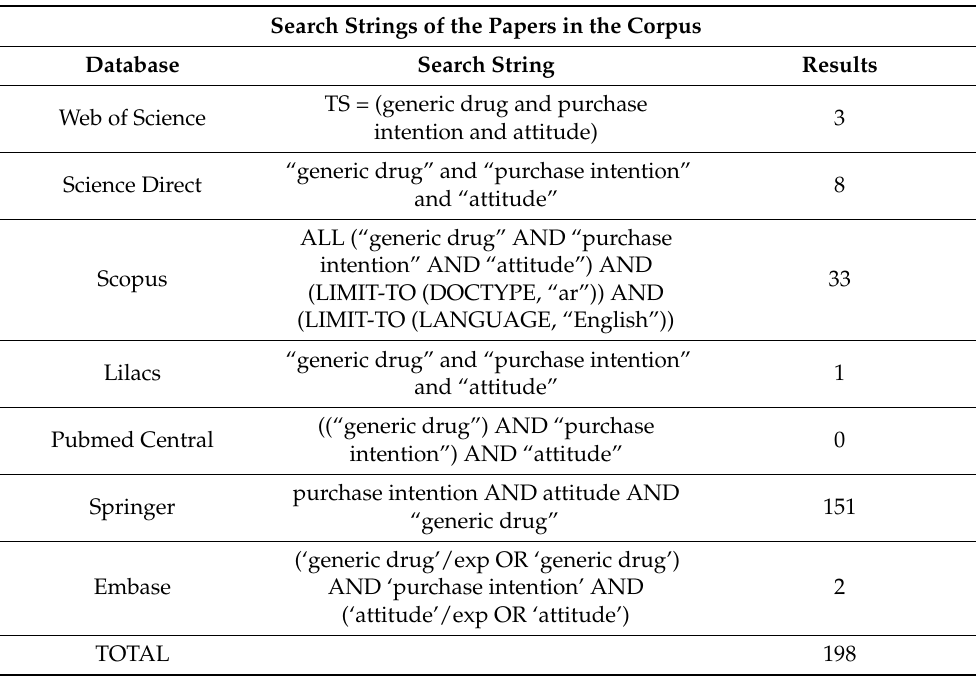
Table 1. Search Strings applied to databases, and number of articles resulting from the search. Search Strings of the Papers in the